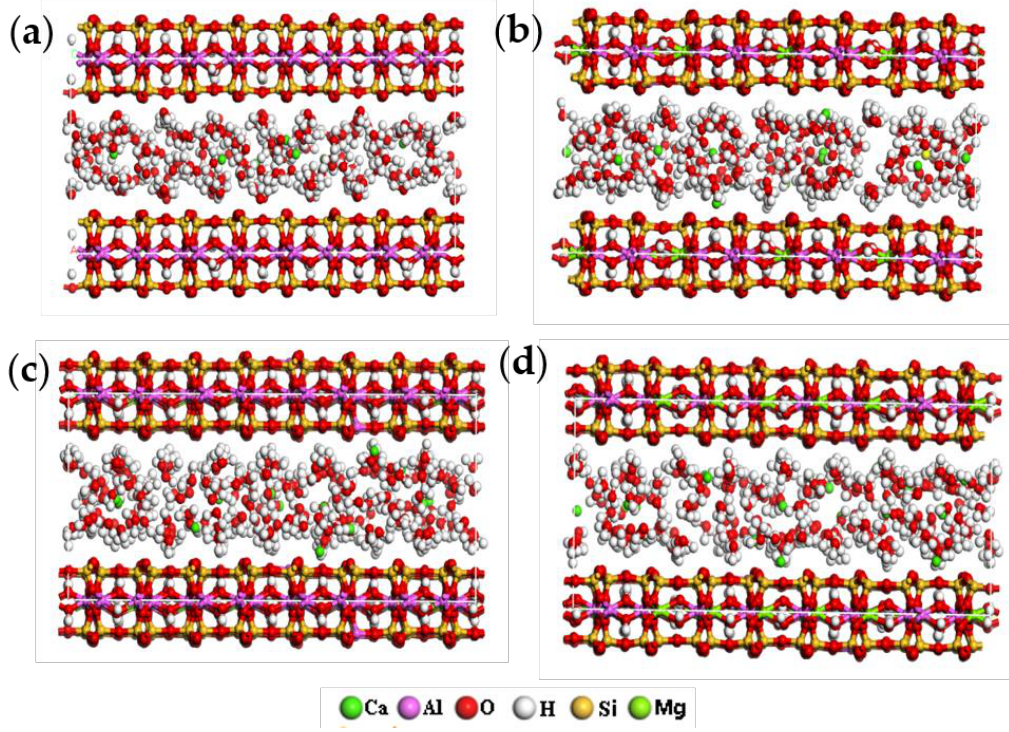
Figure 2. The hydration models of montmorillonite (ball-and-stick model) ( a ) 0.375; ( b ) 0.500; ( c ) 0.563; ( d ) 0.688.